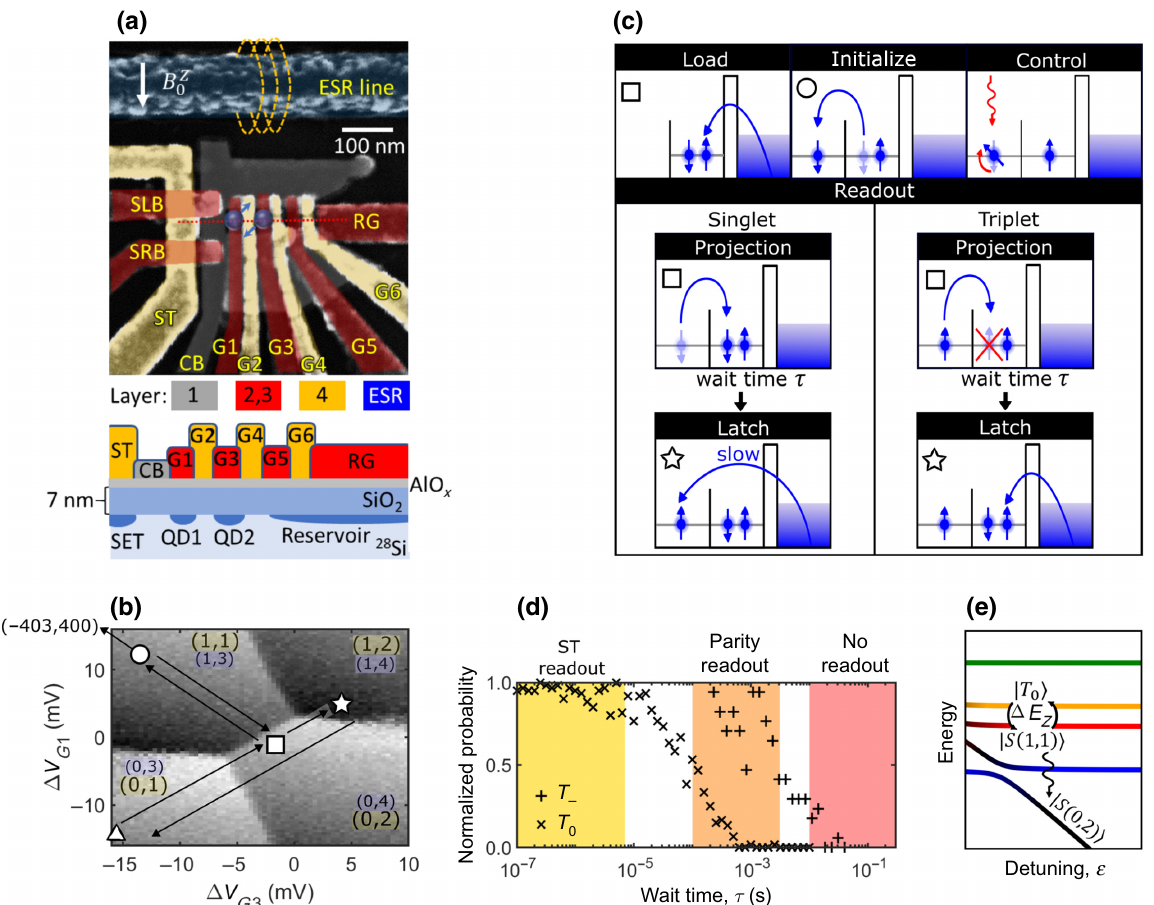
FIG. 1. Pauli spin blockade and latched readout. (a) False-colored scanning electron microscope (SEM) image of a device nominally identical to the one used in the experiments. The dashed line shows the location of the cross section of the device represented at the bottom of the image. (b) The charge stability diagram showing the electron occupancy in the device. The valence electrons in each dot are shown by the numbers highlighted in yellow; the actual electron occupancy is shown by the numbers highlighted in blue. The arrows show the different loading and unloading stages of the experiment and the symbols represent the different stages of the experiment. The circle represents the initialization point, which is beyond the region of the stability diagram shown here (the arrow pointing out of the figure represents this). (c) A diagram representing the different stages of the experimental process and how the Pauli blockade allows for spin readout. The decay of | T 0 (cid:2) and | T − (cid:2) triplets is shown in (d) as a function of wait time τ at the blockade region near the (1,1)-(0,2) transition. We normalize the probabilities of the decay of the states according to their initialization fidelity. (e) Energy diagram showing the Zeeman energy difference coupling the | T 0 ( 1, 1 ) (cid:2) and | S ( 1, 1 ) (cid:2) states. The decay of | S ( 1, 1 ) (cid:2) into | S ( 0, 2 ) (cid:2) is shown by the arrow between the two